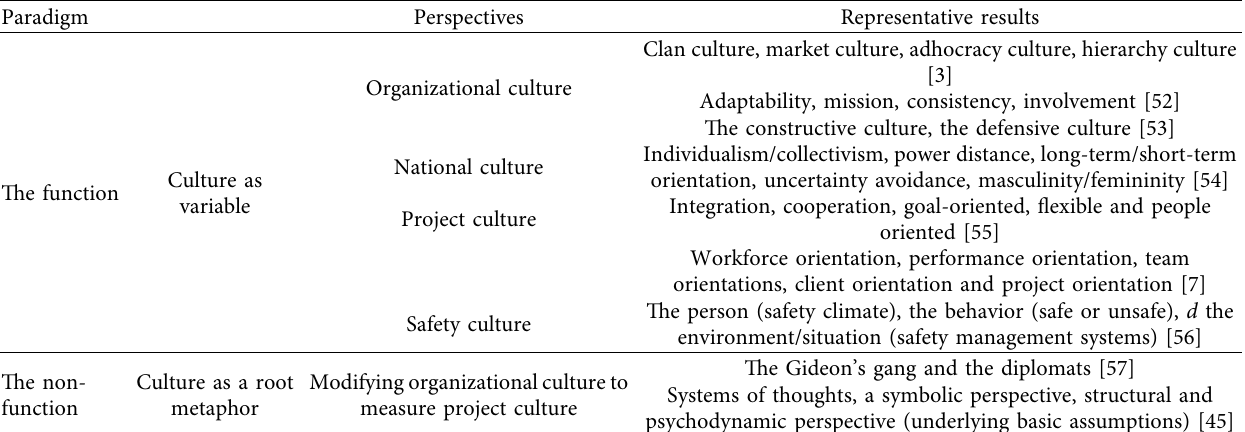
Table 2: The measurement of culture in